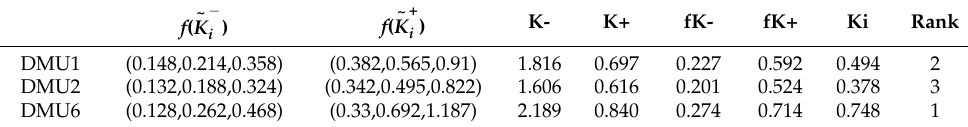
Table 13. Results of the integrated IMF SWARA–fuzzy MARCOS